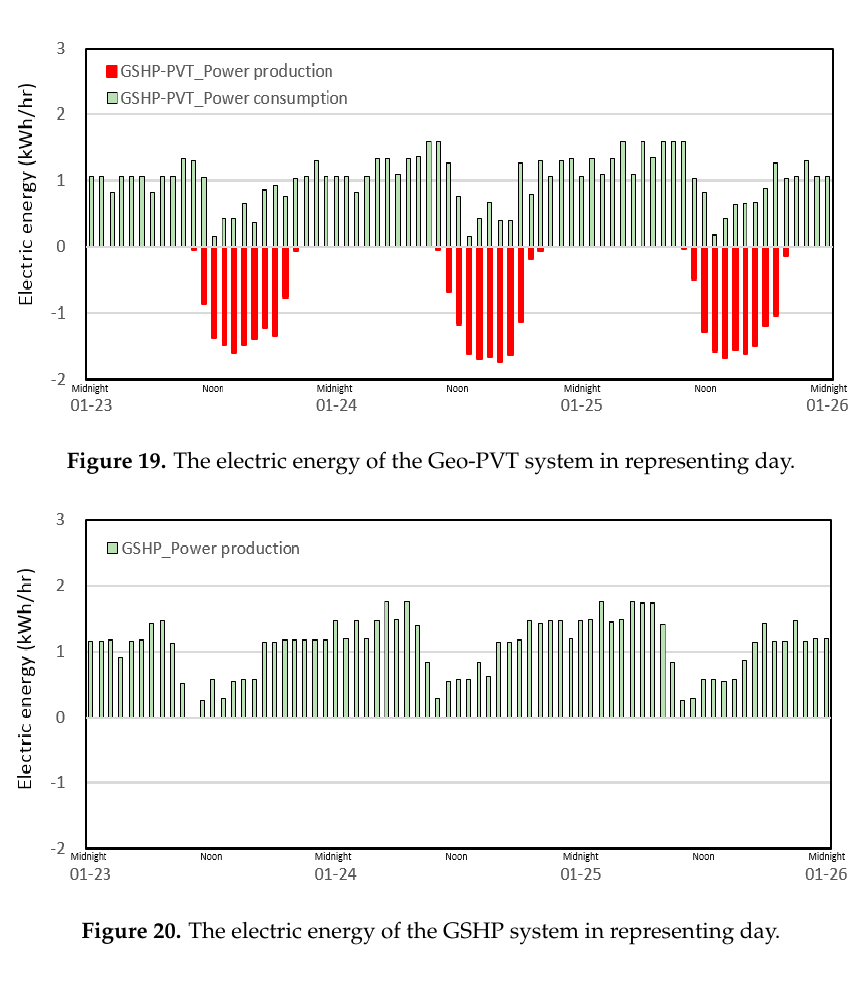
16 of 28 Figure 18. The heat production of the Geo-PVT system during the representing 3-day period. Figures 19 and 20 show the power production and consumption of two systems on the representative days. The Geo-PVT system reduced the power consumption by about 6.5% compared to the existing system by reducing the operation time of the heat pump. The three-day power consumption of the GSHP system was 78 kWh and 73 kWh in the hybrid system. Plus, the hybrid system produced electric power of 35 kWh for 3 days through power generation of the PVT system. The performance coefficient of the system was calculated by using the thermal energy production, power consumption and production. As a result of calculation of the coefficient of